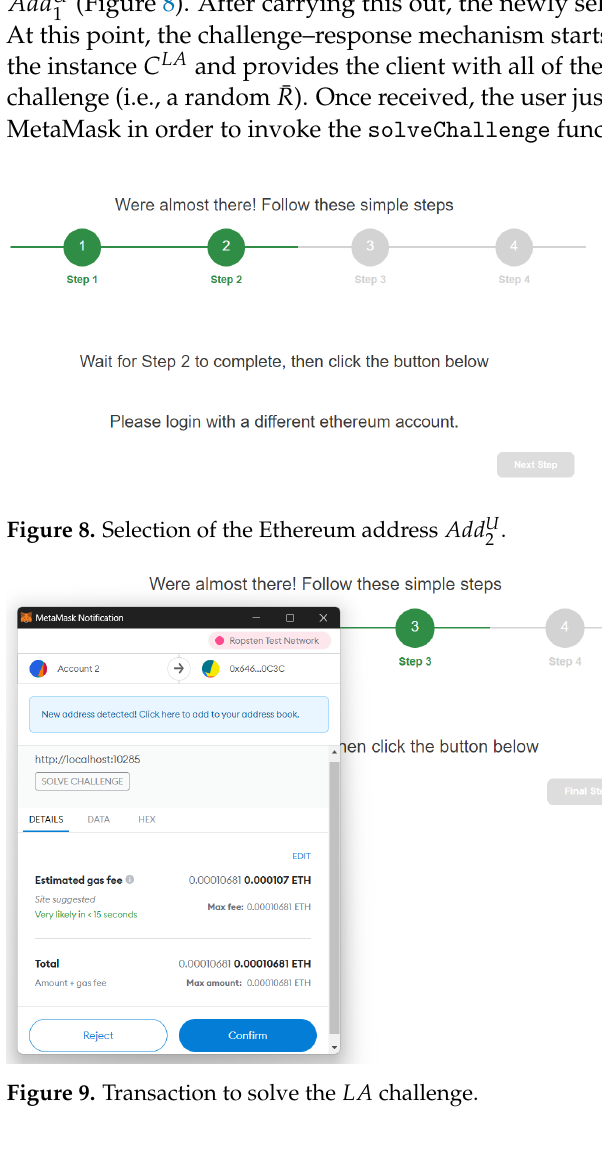
Figure 9. Transaction to solve the LA